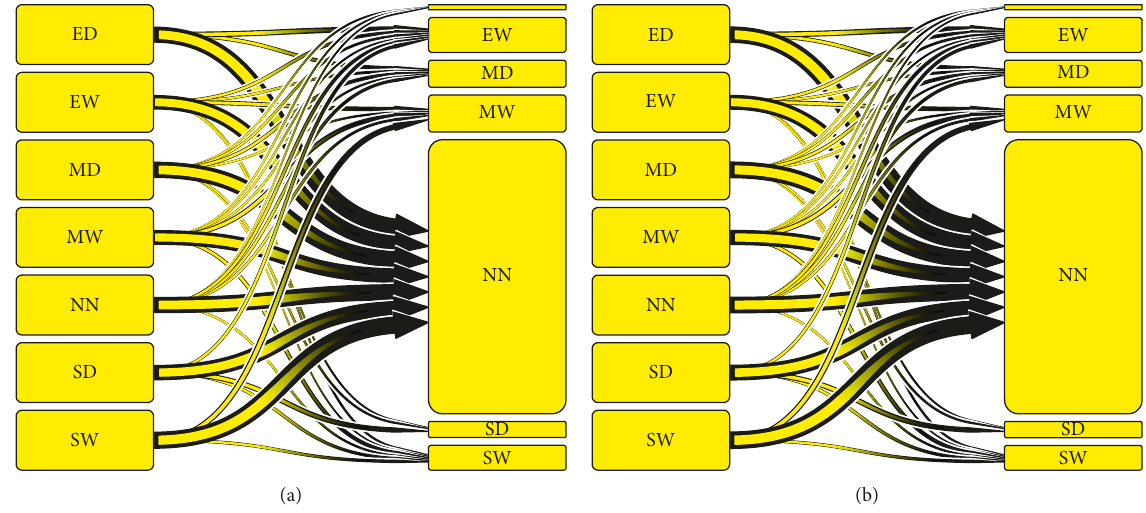
Figure 6: Visual representation of drought classes transitions. (a) Peshawar. (b) Cherat. Table 4: One-month ahead probabilities under weighted Markov chain and Steady State